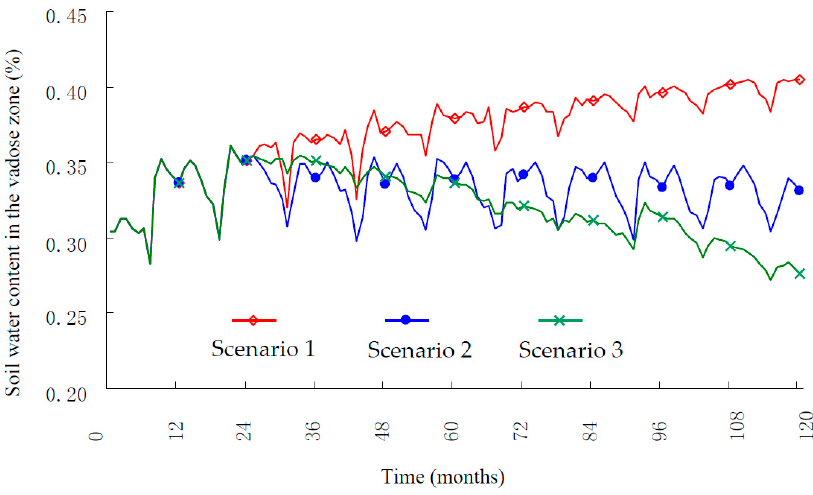
Figure 7. The water content in the vadose zone.